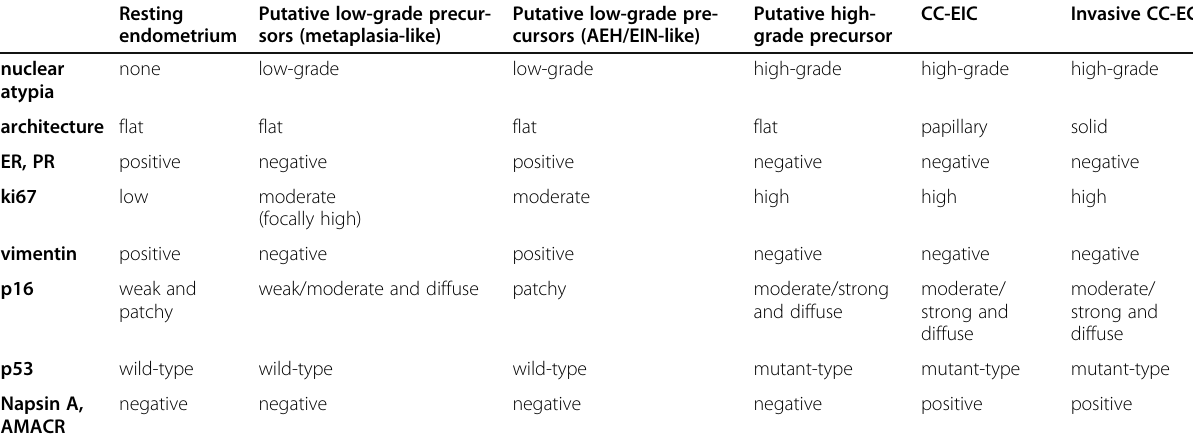
Table 1 Morphological and immunohistochemical features of normal endometrium and putative CCC precursors Resting Putative low-grade precur- endometrium sors (metaplasia-like)